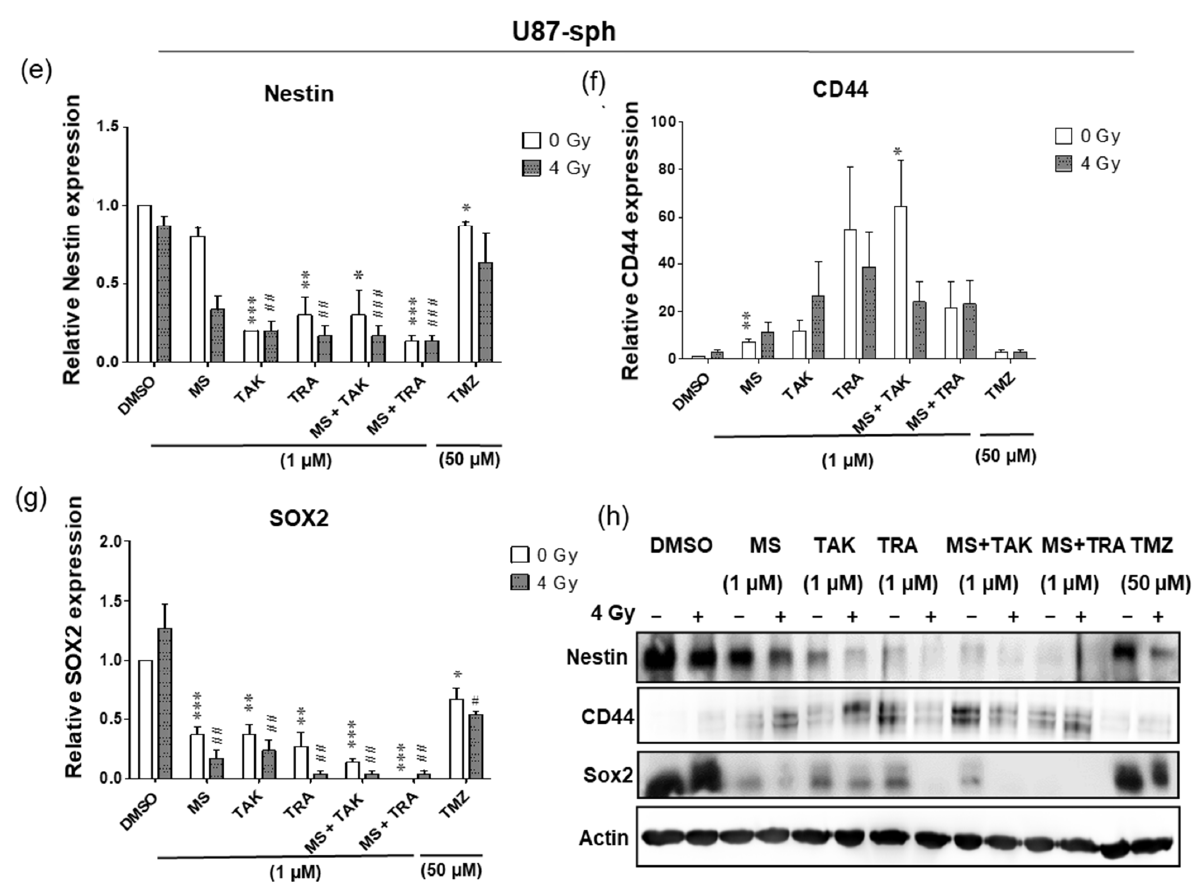
Figure 4. Differential responses of GB-derived spheres to the combination of HDAC and MEK inhibition with radiation. ( a ) U251-sph protein levels of Nestin, ( b ) CD44 and ( c ) SOX2 72 h after the spheres were treated with HDCAi (1 µM MS-275), MEKi (1 µM TAK-733 or 1 µM trametinib), a combination of both (1 µM MS-275 + 1 µM TAK-733 or 1 µM MS-275 + 1 µM trametinib) and 50 µM TMZ alone or with 4 Gy radiation. ( d ) Representative Western blots of GSLC marker protein levels in U251-sph. ( e ) U87-sph protein levels of Nestin. ( f ) CD44 and ( g ) SOX2 after the GSLCs were treated with HDCAi (1 µM MS-275), MEKi (1 µM TAK-733 or 1 µM trametinib), a combination of both (1 µM MS-275 + 1 µM TAK-733 or 1 µM MS-275 + 1 µM trametinib) and 50 µM TMZ alone or with 4 Gy radiation. ( h ) Representative Western blots of GSLC marker protein levels in U87-sph. Relative GSLC marker expressions were first normalized to Actin and then to the sham irradiated control cells treated with DMSO. n = 3; ± SEM. Asterisks indicate significant differences between 0 Gy DMSO and treated samples using Student’s t -test: * p ≤ 0.05, ** p ≤ 0.01 and *** p ≤ 0.001, while hash symbols indicate significant differences between 4 Gy DMSO and 4 Gy treated samples using Student’s t -test: # p ≤ 0.05, ## p ≤ 0.01 and ### p ≤ 0.001.